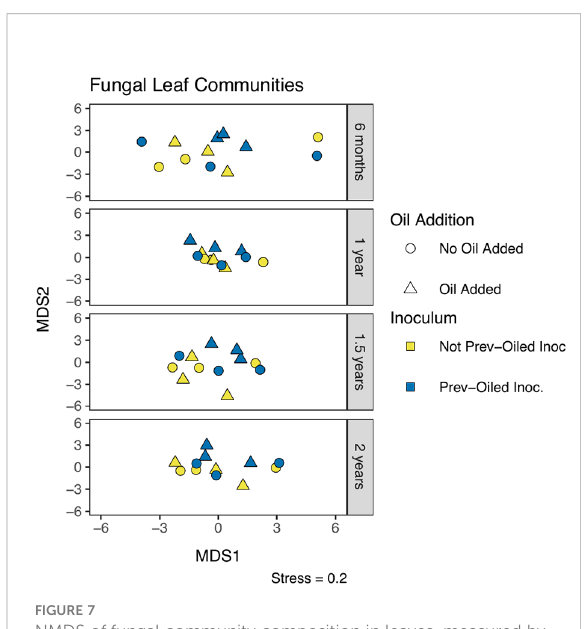
FIGURE 7 NMDS of fungal community composition in leaves, measured by Aitchison distance. Each point represents a single replicate at a time point. Sampling points correspond to individual panels, chronologically from top to bottom. The oil addition treatment is represented by shape and the inoculum treatment by